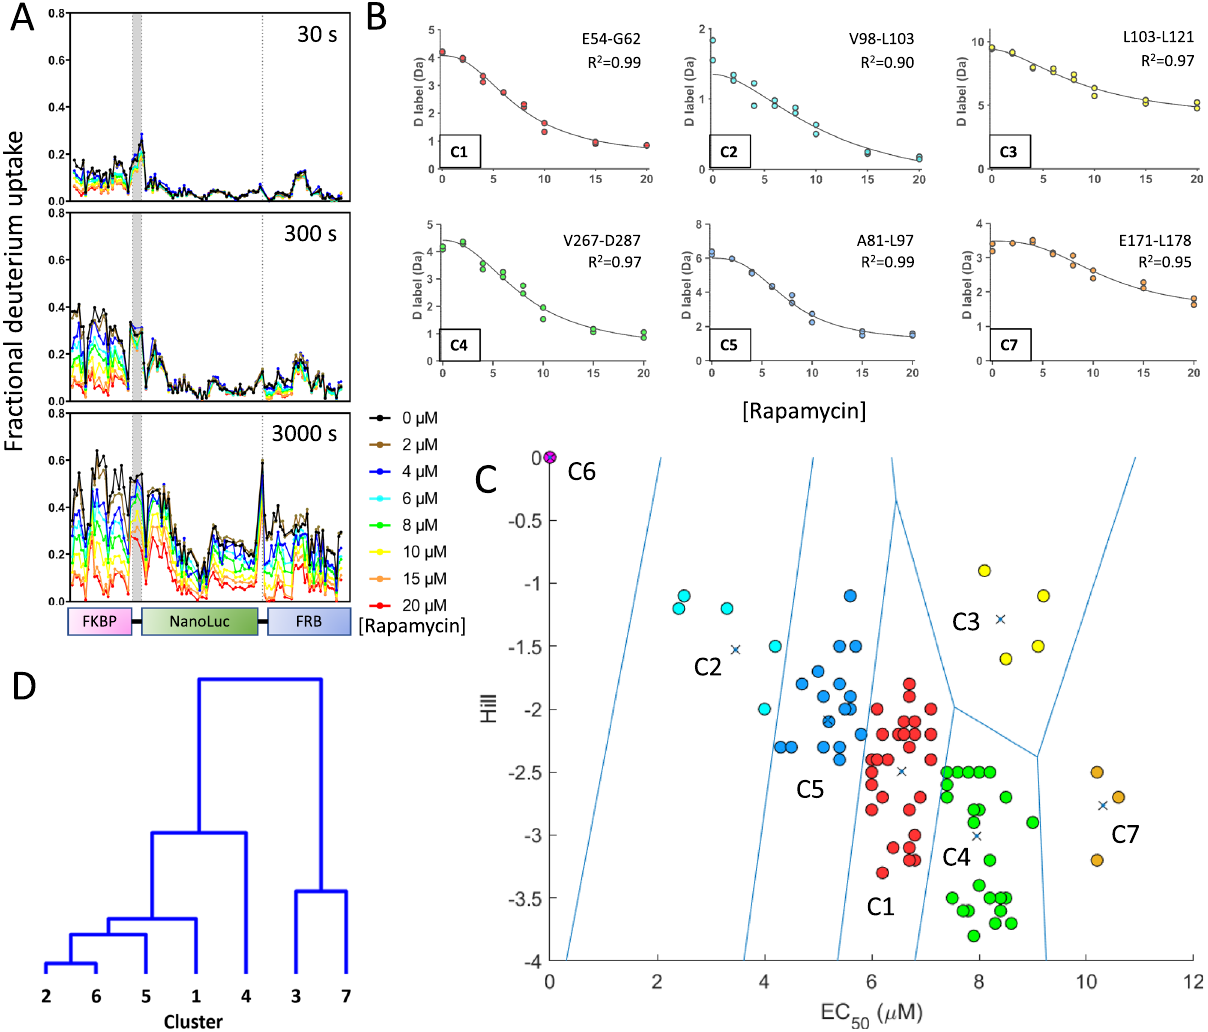
Fig. 4 Binding of rapamycin induces signi fi cant orthosteric and allosteric changes in the structural ensemble of FKBP-cpNanoLuc-FRB with coherent behavior. A Fractional deuterium labelling at three mixing times (30, 300, and 3000 s) as a function of rapamycin concentration (0, 2, 4, 6, 8, 10, 15, and 20 µ M) binding to 8 µ M FKBP-cpNanoLuc-FRB. Protein domains shown below on the x -axis. Gly-rich linkers between domains as dashed vertical lines. B Unprocessed HDX-MS labelling data at 3000 s mixing time as a function of rapamycin concentration are shown for representative peptides of each cluster (except C6 rapamycin-independent regions). Fit to a Hill equation (black trace). C Rapamycin dose-response of each amino acid in the biosensor protein (as de fi ned by EC 50 and Hill coef fi cients from fi t to Hill equation) was clustered with a k-means method. HDX-MS measurements were averaged per amino acid from peptide-level data and summed across all time points. Centroid of each cluster (C1 – C7) denoted by x ; Voronoi boundaries — blue lines. D Dendrogram of families from clustering in C . Y -axis — linkage (arbitrary units in Euclidean space). Source data are provided as a Source Data fi